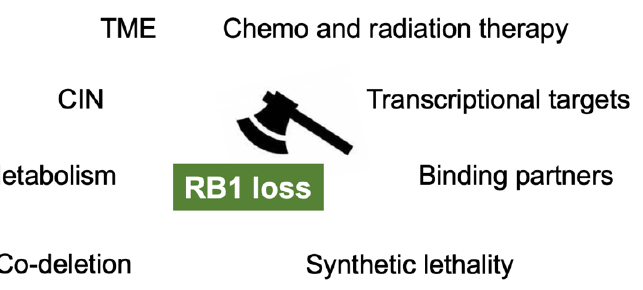
Figure 2. The mechanisms which enable us to target RB1 loss in cancers. TME: tumor microenviron- ment; CIN: chromosomal instability.